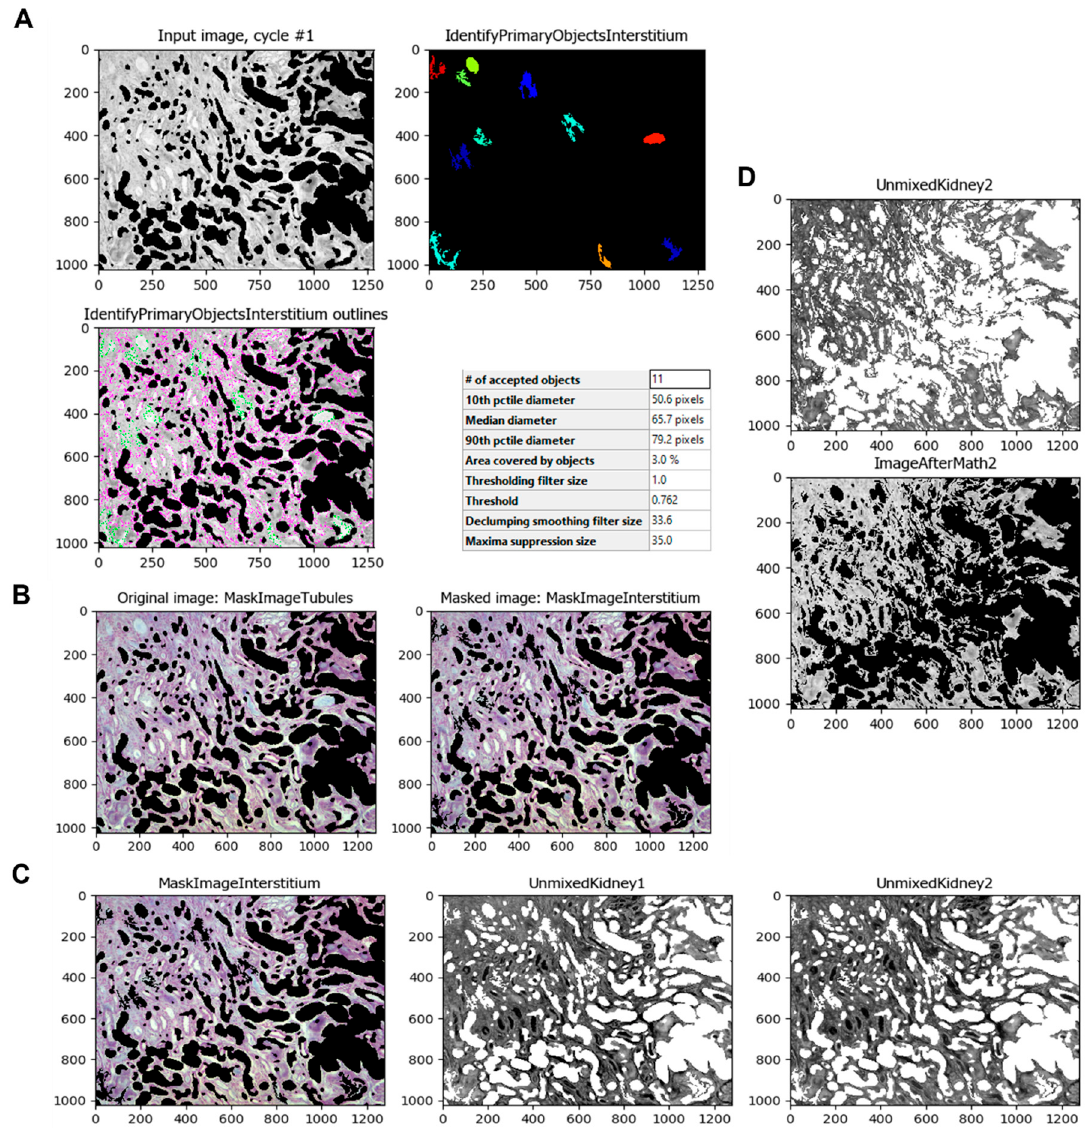
Figure 6. Identification of small areas of the renal interstitium and inside tubules, and separation of Masson’s trichrome stain colors. ( A ) The IdentifyPrimaryObjects module identifies the normal renal interstitium and other non-fibrotic areas. ( B ) The MaskImage module masks the tubule-less image with the normal renal interstitium image. ( C ) The UnmixColors module separates the image of the stains Methyl Blue (collagen) and Ponceau-fuchsin (Masson’s Trichrome red counterstain). ( D ) The ImageMath module inverts the image obtained by the unmixing process.